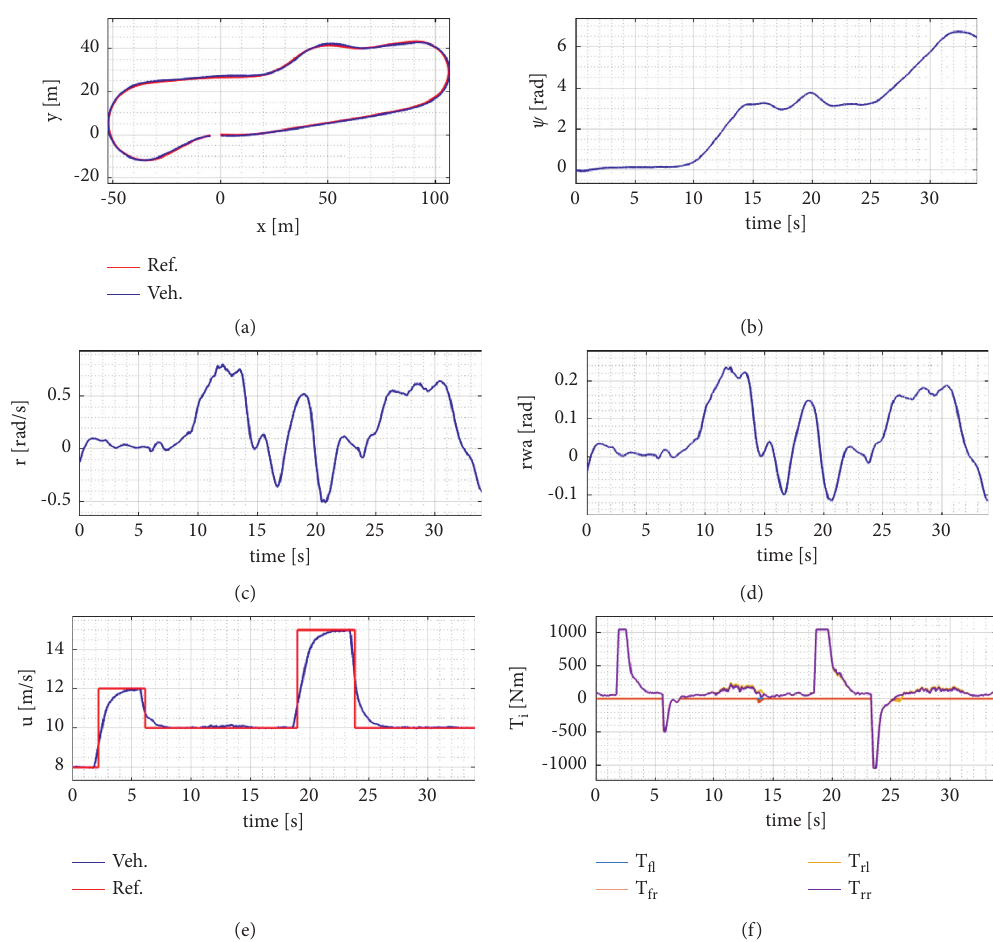
Figure 9: The cascade controller in work, following the path and tracking speed reference. (a) Path. (b) Heading. (c) Yaw rate. (d) Road- wheel angle. (e) Longitudinal velocity. (f) Wheel